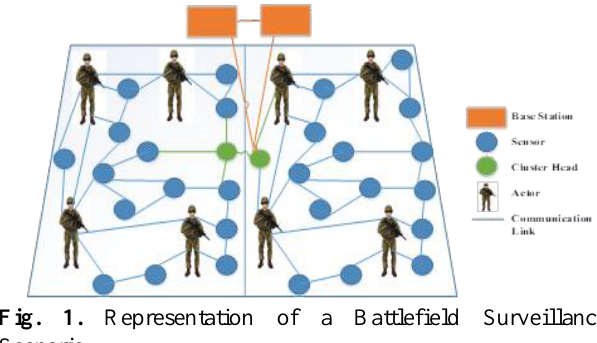
Fig. 1. Representation of a Battlefield Surveillance